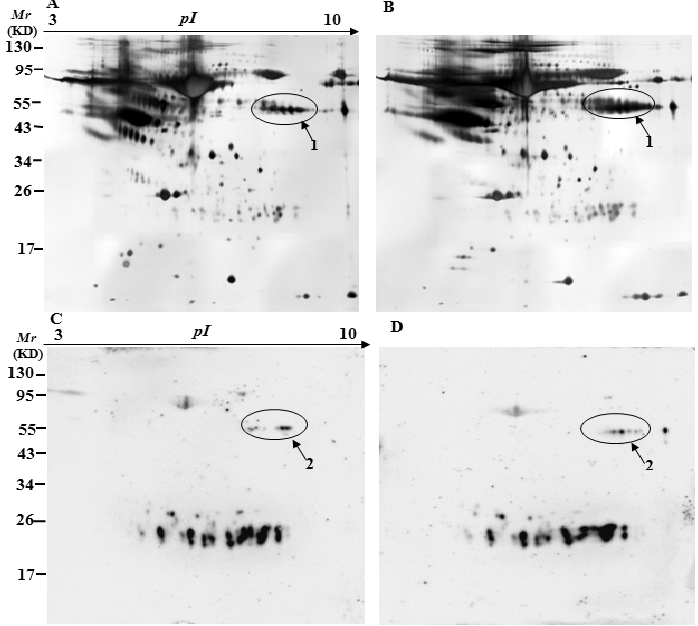
Figure 4. Silver-stained gels and 2D-oxyblots of the serum extracts from six-month-old controls to 3×Tg-AD mice. Representative 2D gel images of the serum proteomes of the control ( A ) and 3×Tg-AD mice ( B ); ( C , D ) are the oxyblots of serums from the control to 3×Tg-AD mice, respectively. Spots that showed a significant difference in specific carbonylation levels are marked with the corresponding protein identity.